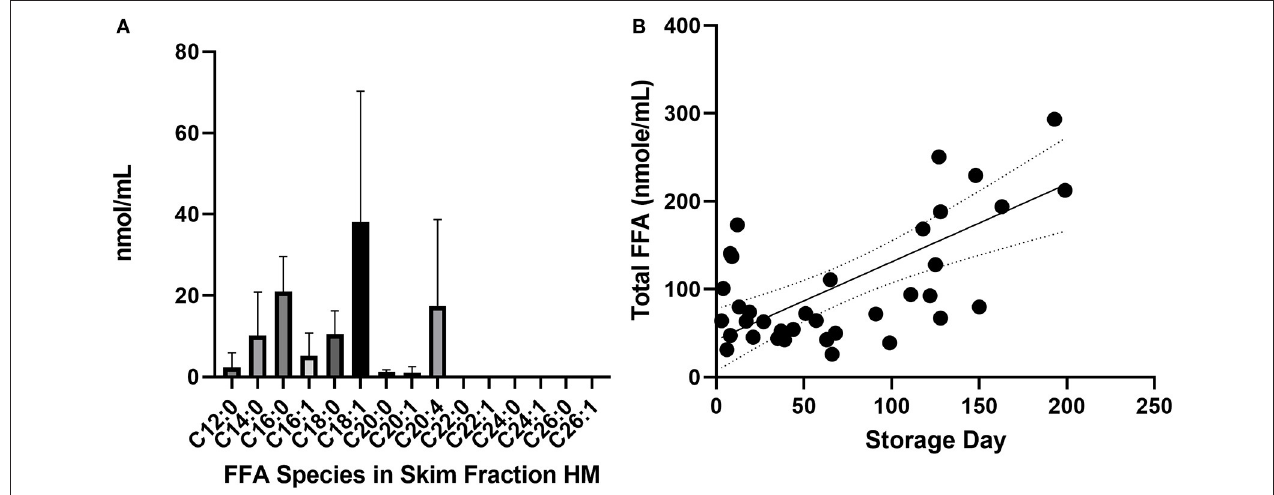
FIGURE 1 | Common species of FFA present in skimmed milk. (A) Average concentration of FFA species in undiluted skimmed human milk samples analyzed by UHPLC-tandem MS. Error bars show standard deviation (a) and dotted lines are 95% C.I. around the mean (b). Long chain fatty acids longer than C20 were < 1 nmol/mL and below the limit of detection. (B) Total FFA content after stored at − 20 ◦ C, p ≤ 0.0001, n = 34 samples, 15 mothers. FFAs, free fatty acids; UHPLC, ultra high performance liquid chromatography; MS, mass spectrometry.